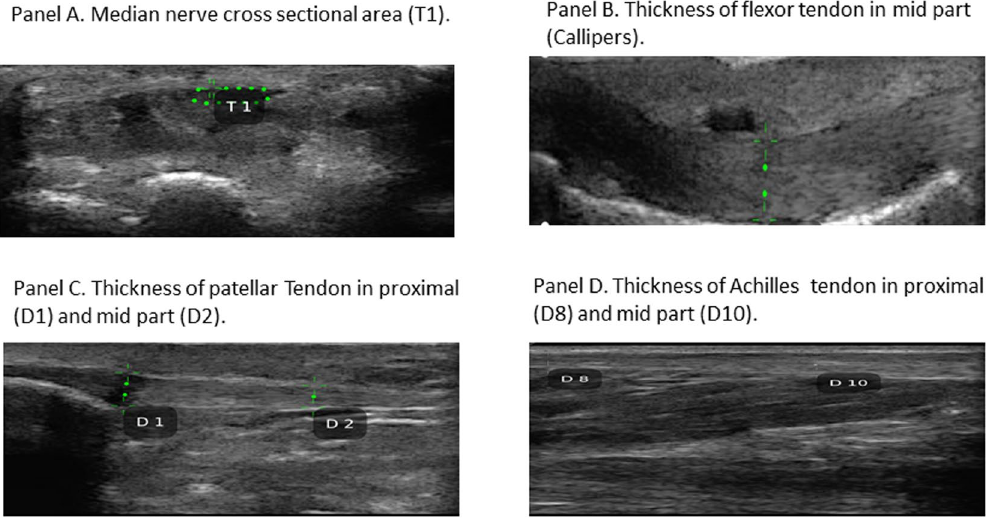
Figure 1. An overview divided in Panels (A–D) of the measurements of the median nerve cross sectional area and of tendon thickness using the handheld sonographic